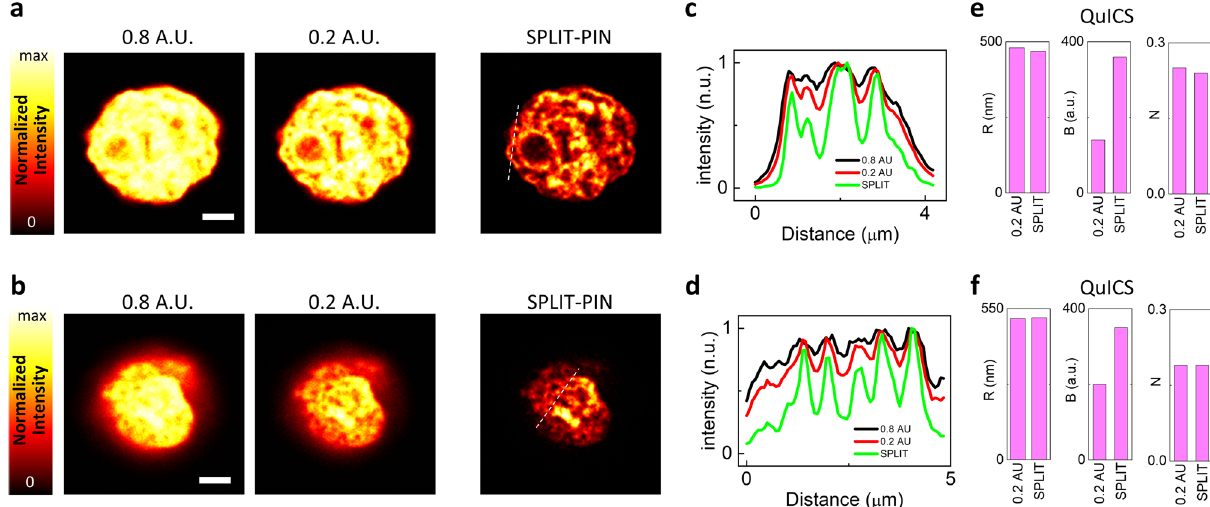
Figure 2. SPLIT-PIN imaging of DNA in non-adherent cell nuclei. ( a , b ) SPLIT-PIN imaging of fixed U937-PR9 cell nuclei labeled with the DNA dye To-Pro-3. Shown are confocal images acquired at 0.8 A.U. and 0.5. A.U. and the corresponding SPLIT-PIN images. Sections are shown at a mid plane ( a ) and at a bottom plane ( b ) of the nucleus. Scale bars 8 μm ( a ) and 2 μm ( b ). ( c ) Line profiles corresponding to the dashed line in ( a ). ( d ) Line profile corresponding to the dashed line in ( b ). ( e ) Quantification of Resolution (R), Brightness (B) and Noise (N) parameters for the SPLIT-PIN and 0.2 A.U. images shown in ( a ) using the QuICS algorithm.